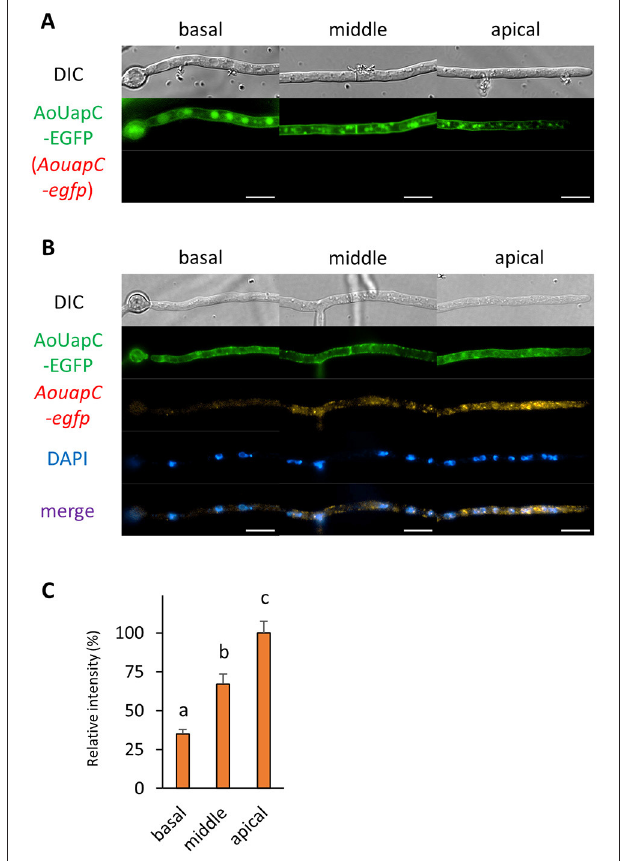
FIGURE 7 | The fluorescence derived from EGFP-AoVam3 protein and egfp-Aovam3 mRNA was observed in hyphal cells of the EGFP-AoVam3-expressing strain. (A) EGFP-AoVam3 was observed in live cells. (B) smFISH with egfp probe resulted in the observation of the fluorescence of EGFP-AoVam3 and egfp-Aovam3 mRNAs. Nuclei were stained with DAPI. Bars, 10 µ m. (C) Relative fluorescence intensity of egfp-Aovam3 mRNA was determined at apical, middle, and basal cells. Bars show mean with standard error. Significant difference at P < 0.05 among each lowercase (Tukey–Kramer test, n = 10 cells).